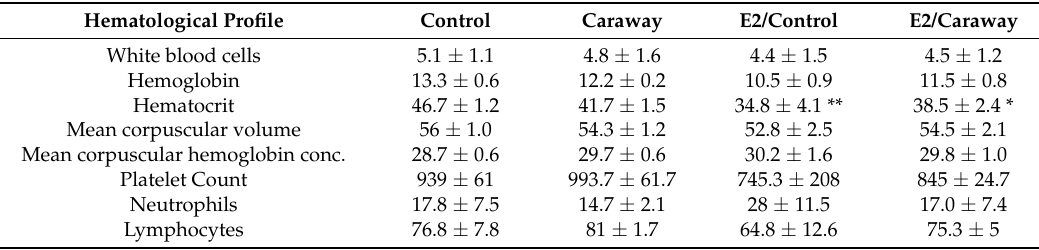
Table 3. The effects of E2 exposure and caraway supplemented diet (7.5%) on the hematological parameters (systemic toxicity) at the tumor time point in ACI